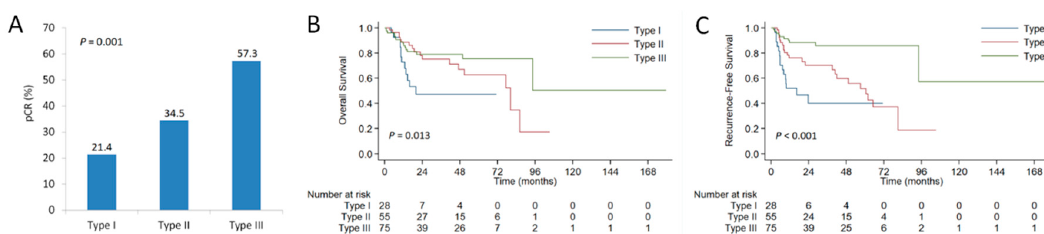
Figure 5. Comparison of pathologic complete response rates according to the co-expression status of IDO1 and PD-L1 ( A ). Kaplan-Meier curves for overall survival ( B ) and recurrence-free survival ( C ) in patients with esophageal squamous cell carcinoma according to the co-expression status of IDO1 and PD-L1. Type I: IDO1 (+)/PD-L1 (+); Type II: IDO1 ( − )/PD-L1 (+) or IDO1 (+)/PD-L1 ( − ); Type III: IDO1 ( − )/PD-L1 ( − ).